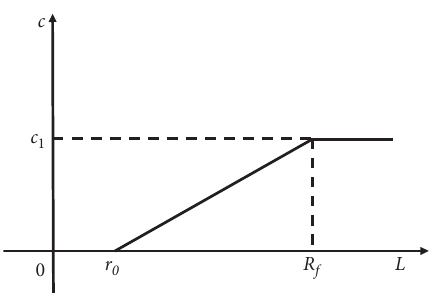
Figure 3: Variation of cohesive around the drilling hole in the plastic zone.